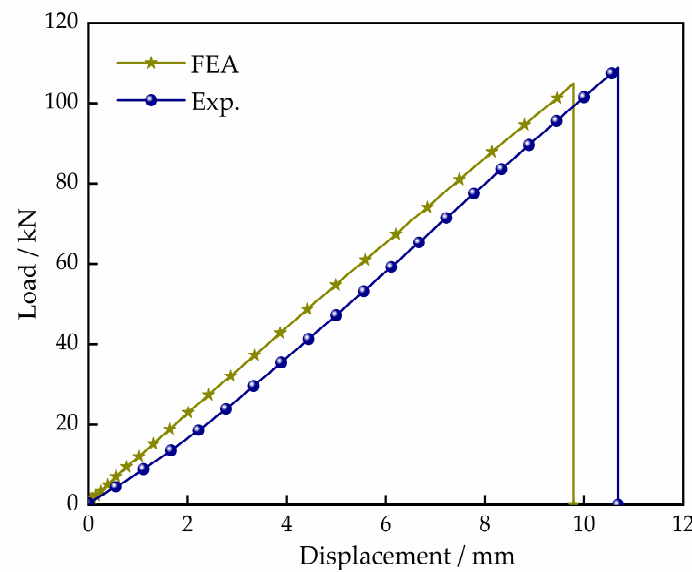
Figure 10. Load–displacement curve of specimen A1 on the basis of test and simulation results.